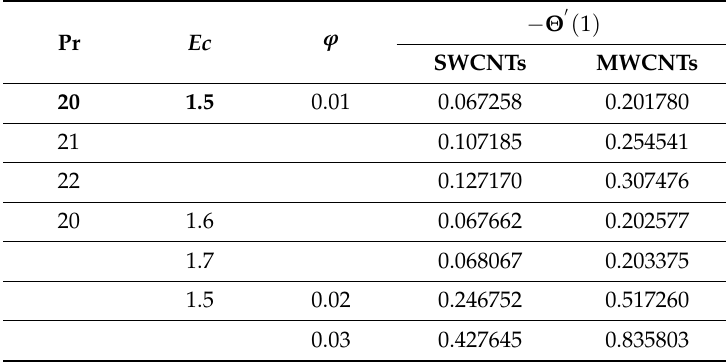
Table 4. The numerical values of the Nusselt number ( − Θ (cid:48) ( 1 ) ). Pr Ec